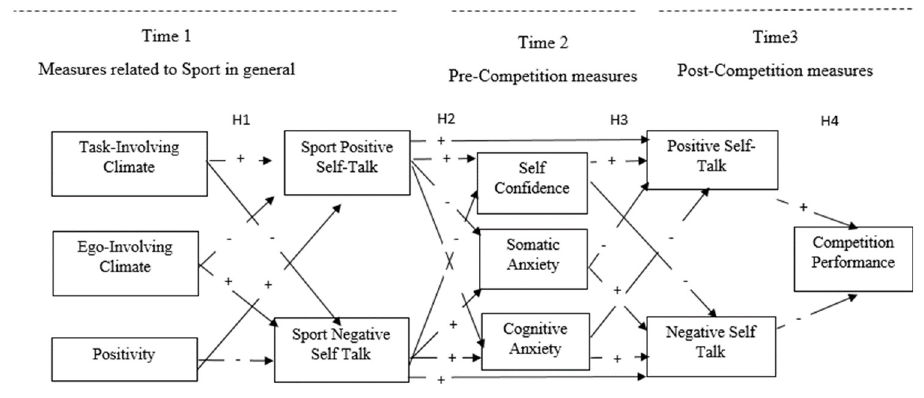
Fig 1. Hypothesised